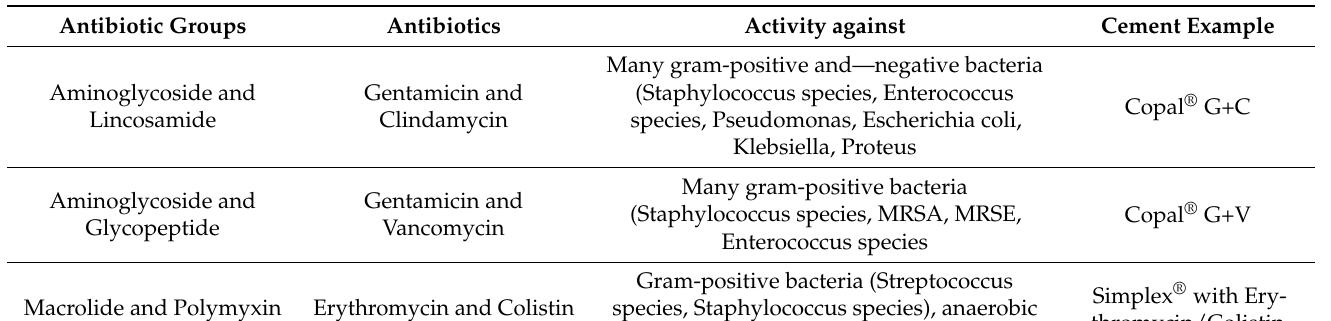
Table A2. Commercially available double loaded bone cements; MRSA: methicillin-resistant Staphy- lococcus aureus; MRSE: methicillin-resistant Staphylococcus epidermidis adapted from Kuhn et al. 2017